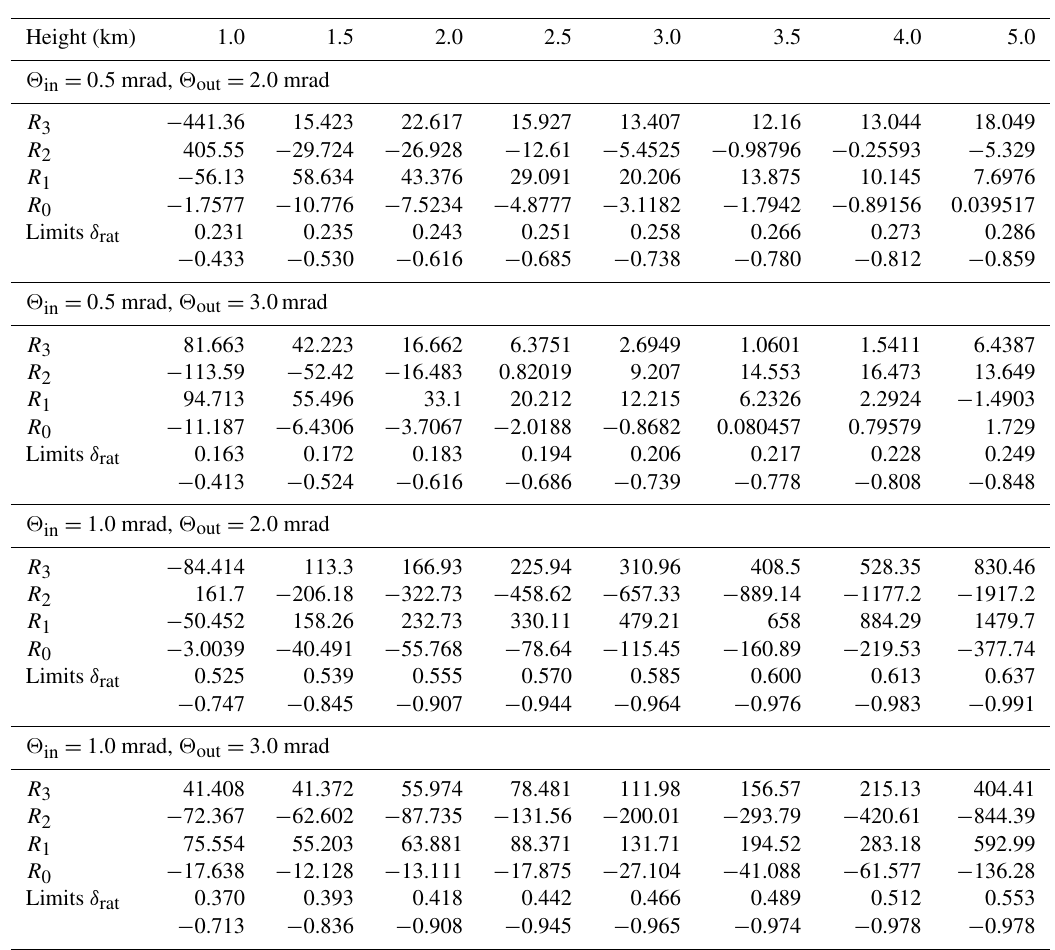
Figure 8. Two-step approach to derive R e (z ref ) and α(z ref ) from δ rat (z bot ,z ref ) and δ in (z bot ,z ref ) for a liquid cloud layer with z bot = 3km and z ref = 3.075km. In the first step (a) , δ rat is used to determine R e (z ref ) by means of Eq. (26), and in the second step (b) , δ in and R e (from step 1) are used to determine α(z ref ) with Eq. (27). In (a) , all simulations with all available combinations of R e – α profile pairs are shown to indicate the low impact of α (given as numbers) on the retrieval. In (b) , the relationship between δ in and α for nine R e values (given as numbers) are shown to indicate the comparably large influence of R e on the α retrieval. Table 2. Polynomial coefficients used in the computation of R e with Eq.